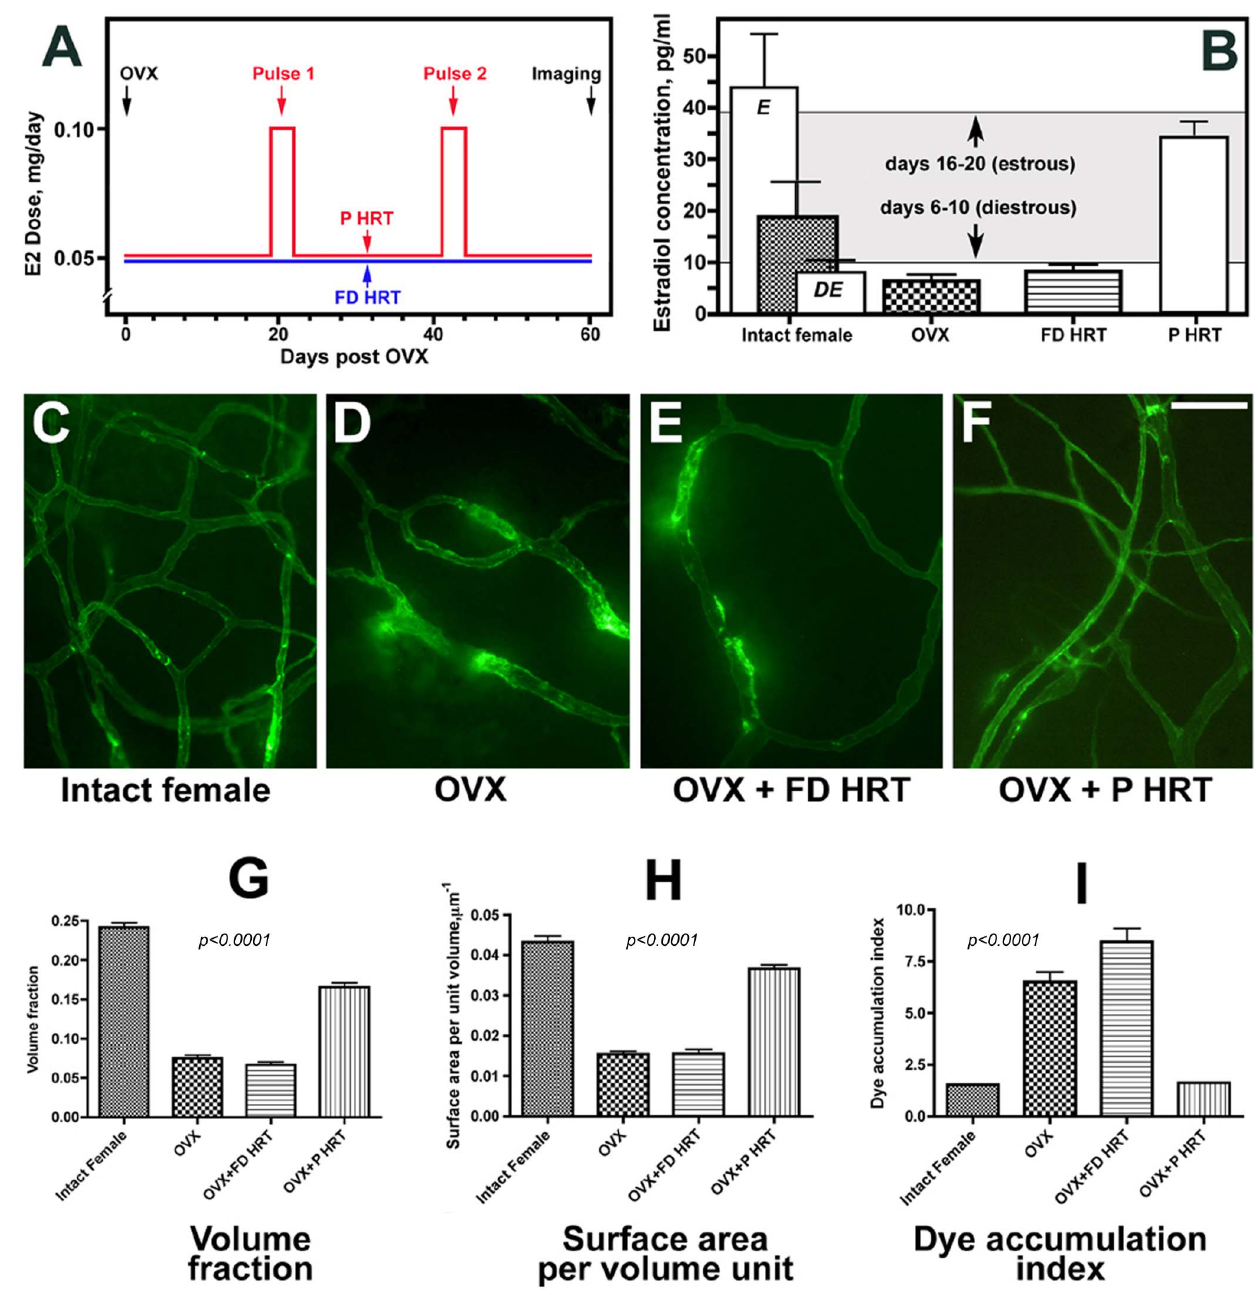
Figure 2. A, Timeline and E2 doses used in OVX + FD HRT (blue line) and OVX + P HRT (red line) experiments. B, Plasma levels of E2 in intact female, OVX, and OVX + HRT pigs. In intact female animals, in addition to the monthly average E2 level (filled bar), estrous and diestrous E2 levels are shown (open bars labeled E and DE respectively). The level of plasma E2 on the peak of a 3-day pulse is shown for OVX + P HRT group. Gray area indicates the magnitude of physiological fluctuations of plasma E2 levels as per literature. C through F, Dura mater microvascular networks of intact female Yucatan miniature pigs (C, N=9), 2 months post OVX (D, N=6), 2 months post OVX in animals receiving FD HRT with 0.05 mg of 17 b -estradiol per day supporting diestrous E2 levels (E, N=4), and 2 months post OVX in animals receiving P HRT mimicking physiological fluctuations in E2 levels (F, N=5). G through I, Response to OVX and different HRT regimens on a tissue volume occupied by terminal microvascular networks (G), blood vessel surface-to-volume ratio (H), and microvessel permeability (I). In G through I, bar graphs show mean 6 standard error of mean. Scale bar shown in F, 100 m m. In B, G, H, and I, IF and OVX data adopted with permission from Ref. 28 to provide reference points for assessing the effects of FD HRT and P HRT.